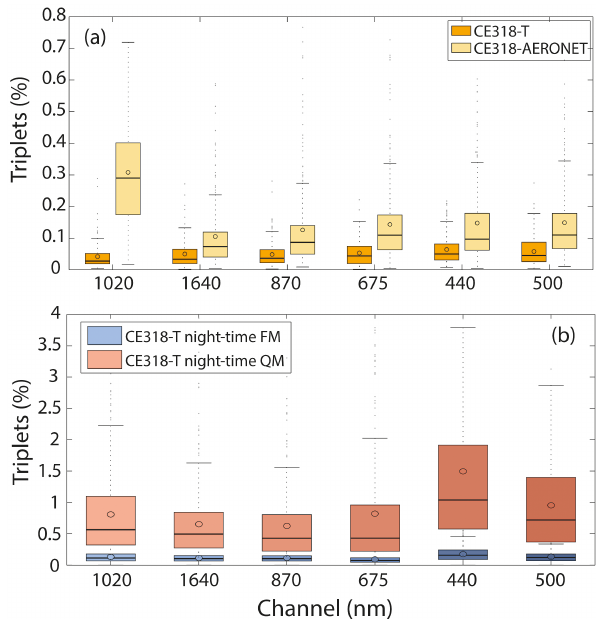
Figure 1. Box plot of triplets (in %) measured at IZO for (a) CE318- T and CE318-AERONET in a daytime period of 23 days from February and March 2015, with pristine conditions (AOD at 500nm ≤ 0.02), and (b) for CE318-T in a night-time period of 7 nights near full moon (FM, in blue) and 5 nights near quarter moon (QM, in red) between January and April 2015. In this figure, circles represent the mean value, while the horizontal line inside each box is the median